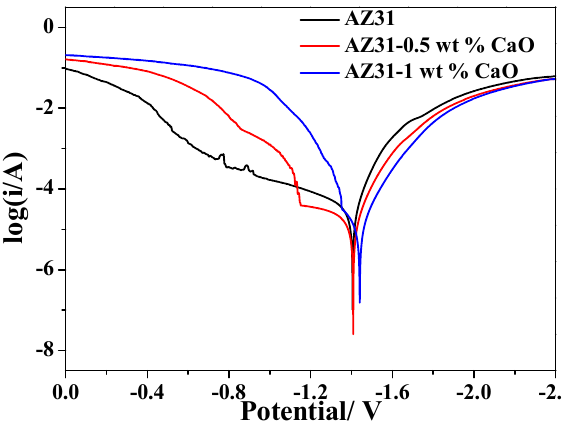
Figure 9. The polarization curves of AZ31-xCaO alloys.